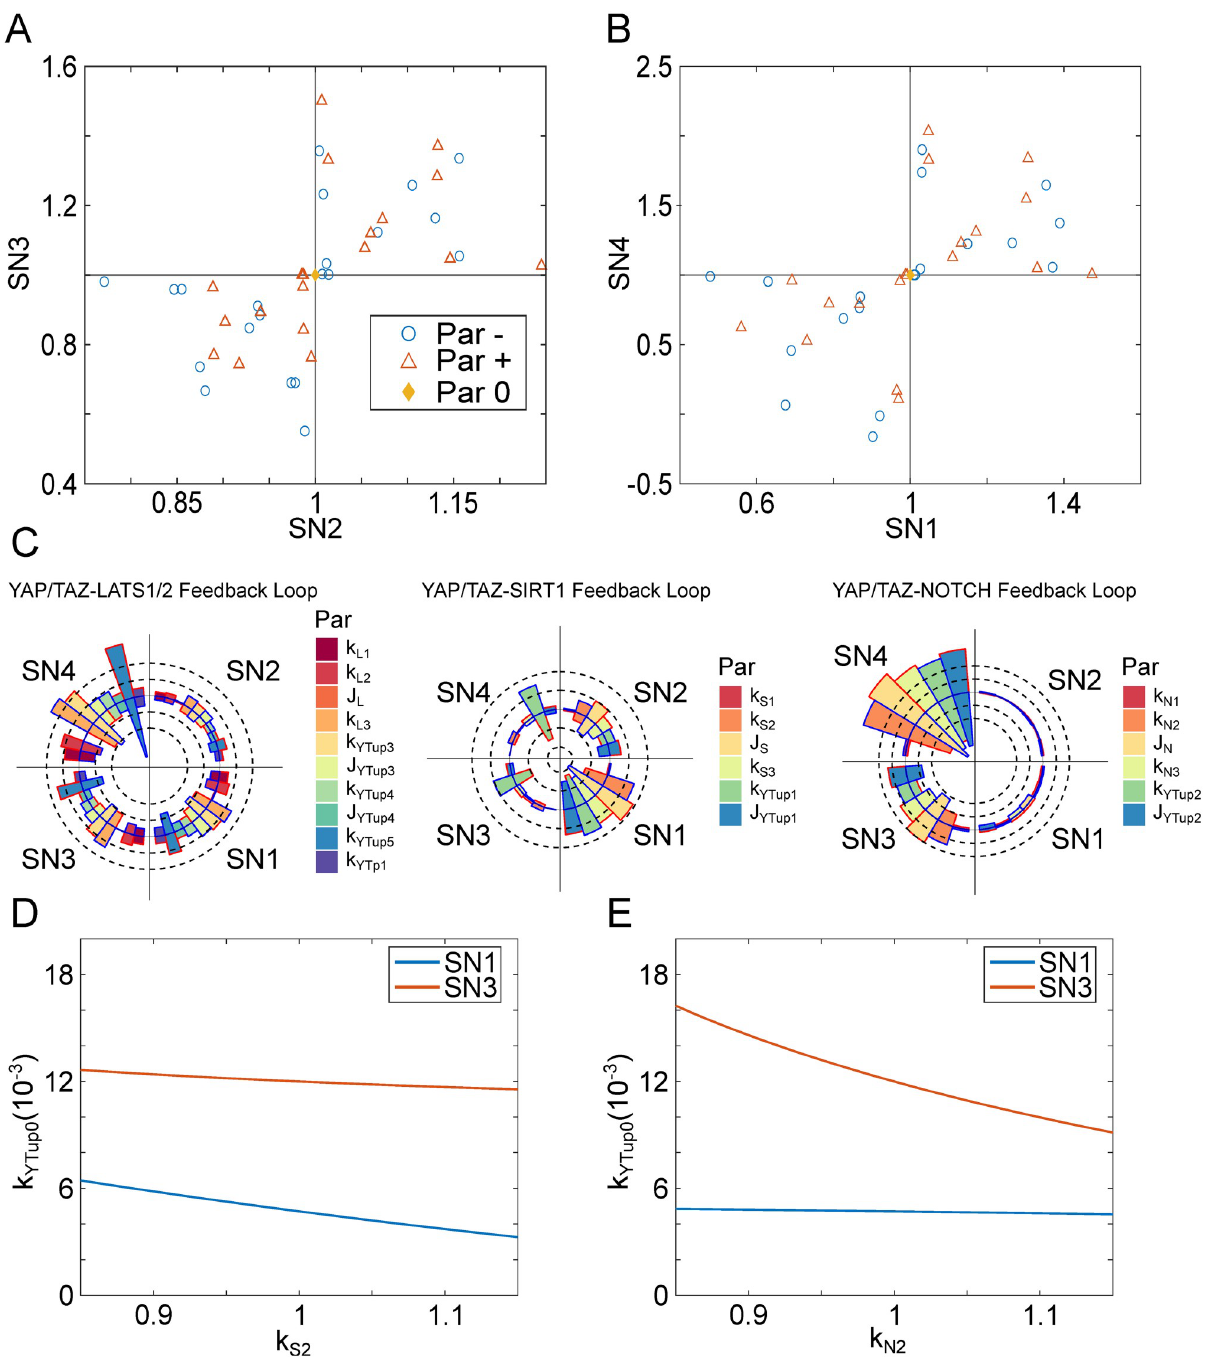
Fig 4. The coupled bidirectional bistable switches are robust to parameter variation. (A-B) Parameter sensitivity analysis was performed for the transition thresholds SN2 and SN3 (A) and SN1 and SN4 (B) by individually increasing and decreasing each parameter by 15% and plotting the fold change. Par- and Par+ represent the increase or decrease of parameters, respectively. Par0 represents the set of standard parameter. The diamond shaped-marker shows the thresholds under the standard parameter set. (C) The circular bar plots show the percent changes in the thresholds when each of the parameters is increased or decreased by 15%. The red outline on the bars denotes an increase of 15% in the parameters, while the blue outline denotes a decrease of 15% in the parameters. The solid black circle represents a 0% change. The dotted black circles going outward and inward represent an increase and decrease of 25% change, respectively. (D-E) Two-parameter bifurcation analyses show the dependence of normalized thresholds for activation of tissue degeneration and tumorigenesis on the strength of (D) the YAP/TAZ-SIRT1 feedback loop ( k S 2 ), and (E) YAP/ TAZ-NOTCH feedback loop ( k ). Par: N 2